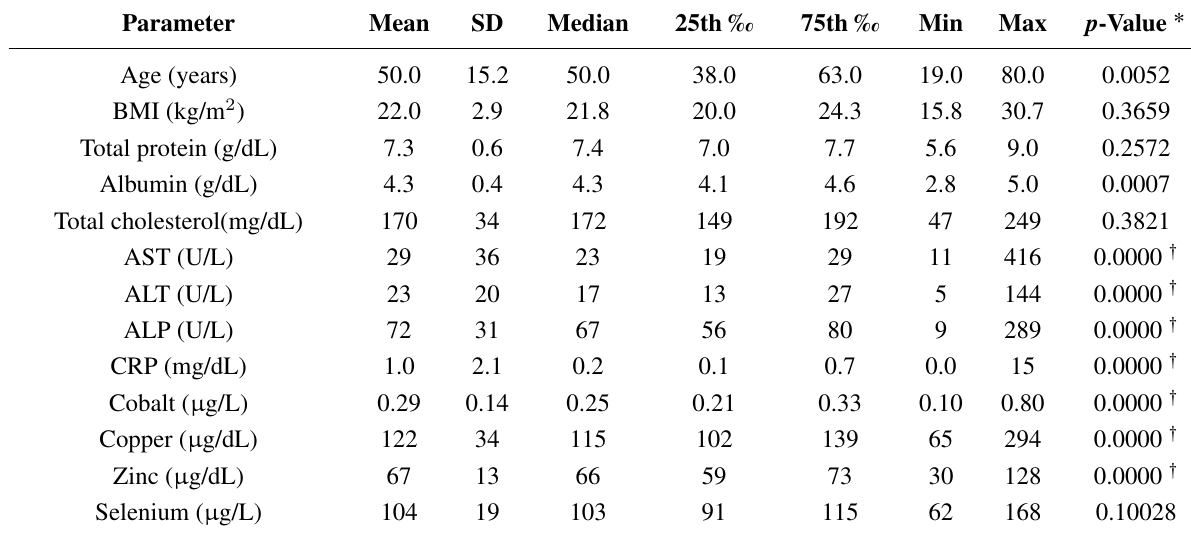
Table 2. Demographic characteristics and trace element concentrations in pulmonary tuberculosis patients ( n =